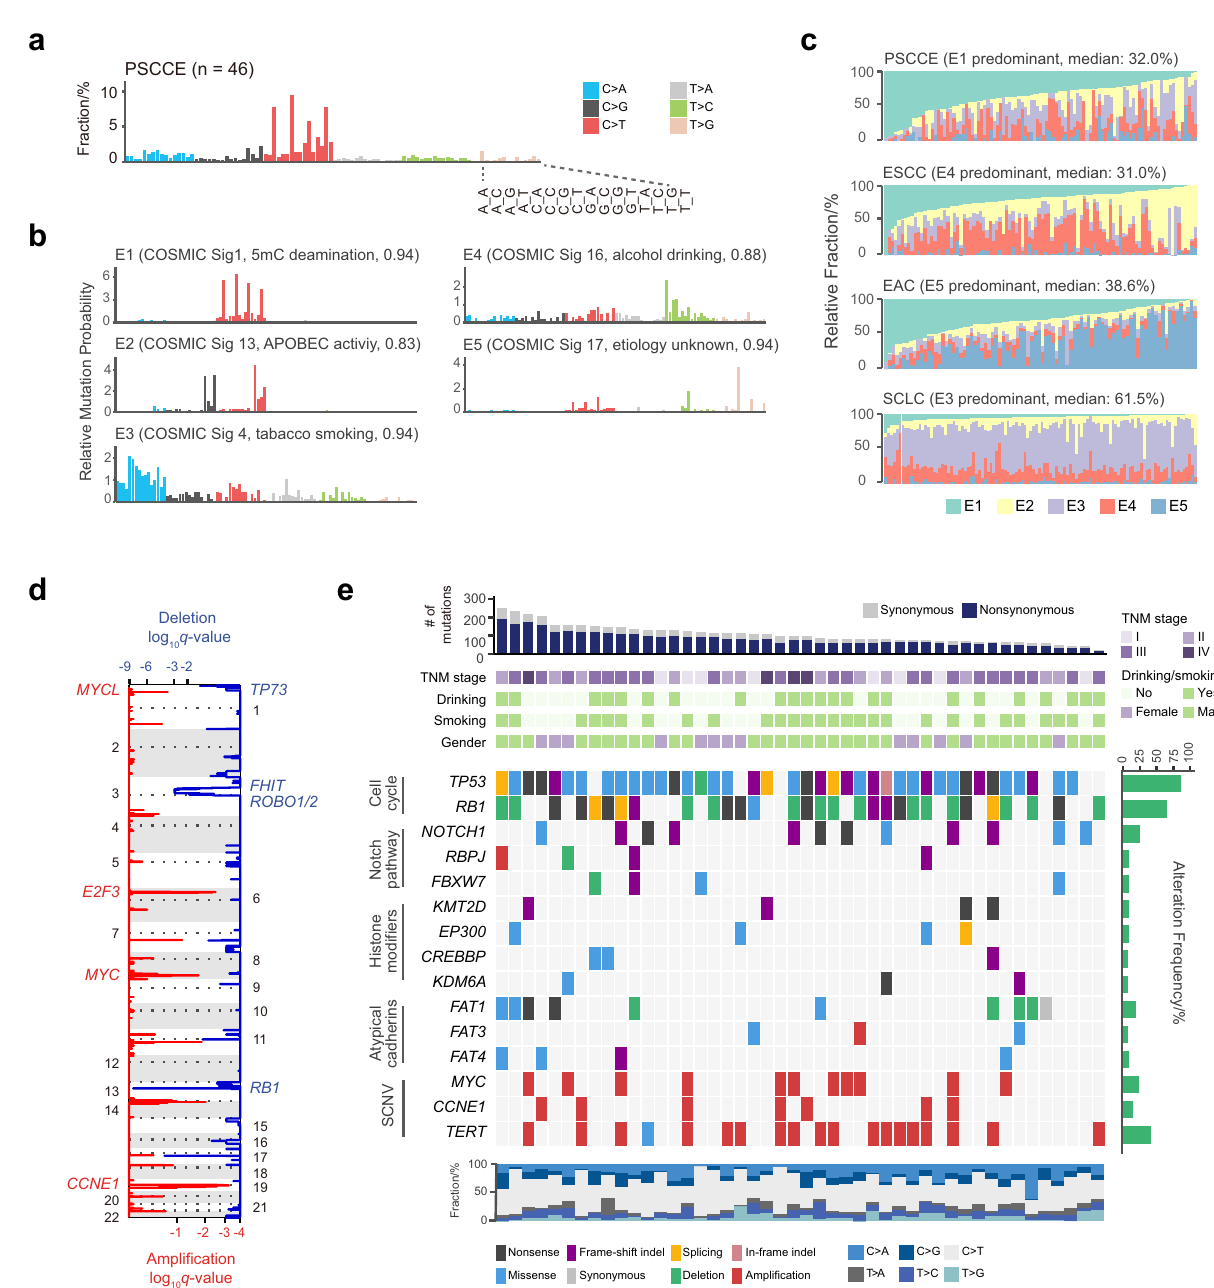
Fig. 1 Genomic alterations detected by WES in PSCCE. a Mutational spectrum of PSCCE. Substitutions are plotted in different colors with their context arranged in the denoted order. b Five mutational signatures, denoted as E1 – E5, were identi fi ed in the integrated analysis of PSCCE, ESCC, EAC, and SCLC. COSMIC signatures showing high similarity, its etiology and cosine similarity score are shown. c The proportions of signature E1 – E5 in each sample of PSCCE, ESCC, EAC, and SCLC tumors. The predominant signature in each cancer is shown. d Recurrent somatic copy-number variations in PSCCE. Ampli fi cations and deletions are plotted in red and blue, respectively. e Landscape of somatic alterations in PSCCE. Somatic alterations of each gene (row) in each tumor (column) are plotted as a heatmap according to the color legend below. Samples are arranged by the number of mutations (top panel). Clinical parameters of each patient are shown below. Alteration frequencies are shown in the right panel. The proportion of single-nucleotide substitutions in each sample is shown in the bottom panel.